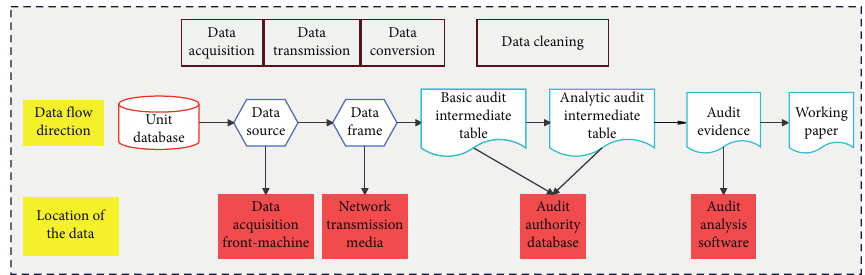
Figure 4: Data flowchart.